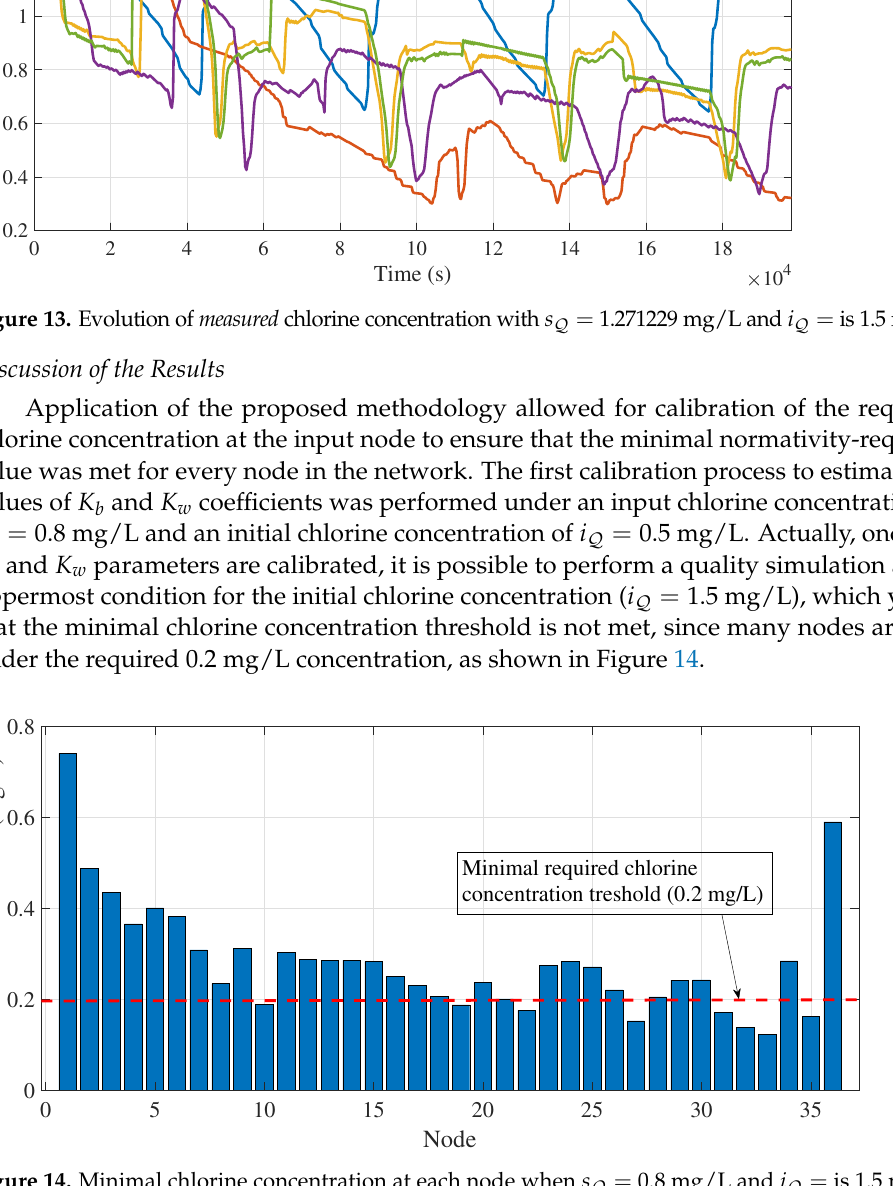
Figure 14. Minimal chlorine concentration at each node when s Q = 0.8 mg/L and i Q = is 1.5